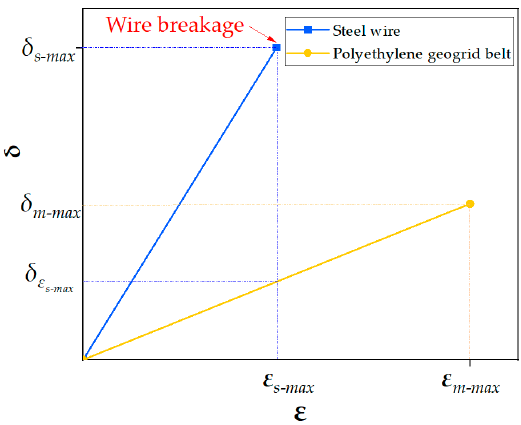
Figure 10. Stress–strain relationship between steel wire and polyethylene geogrid belt.